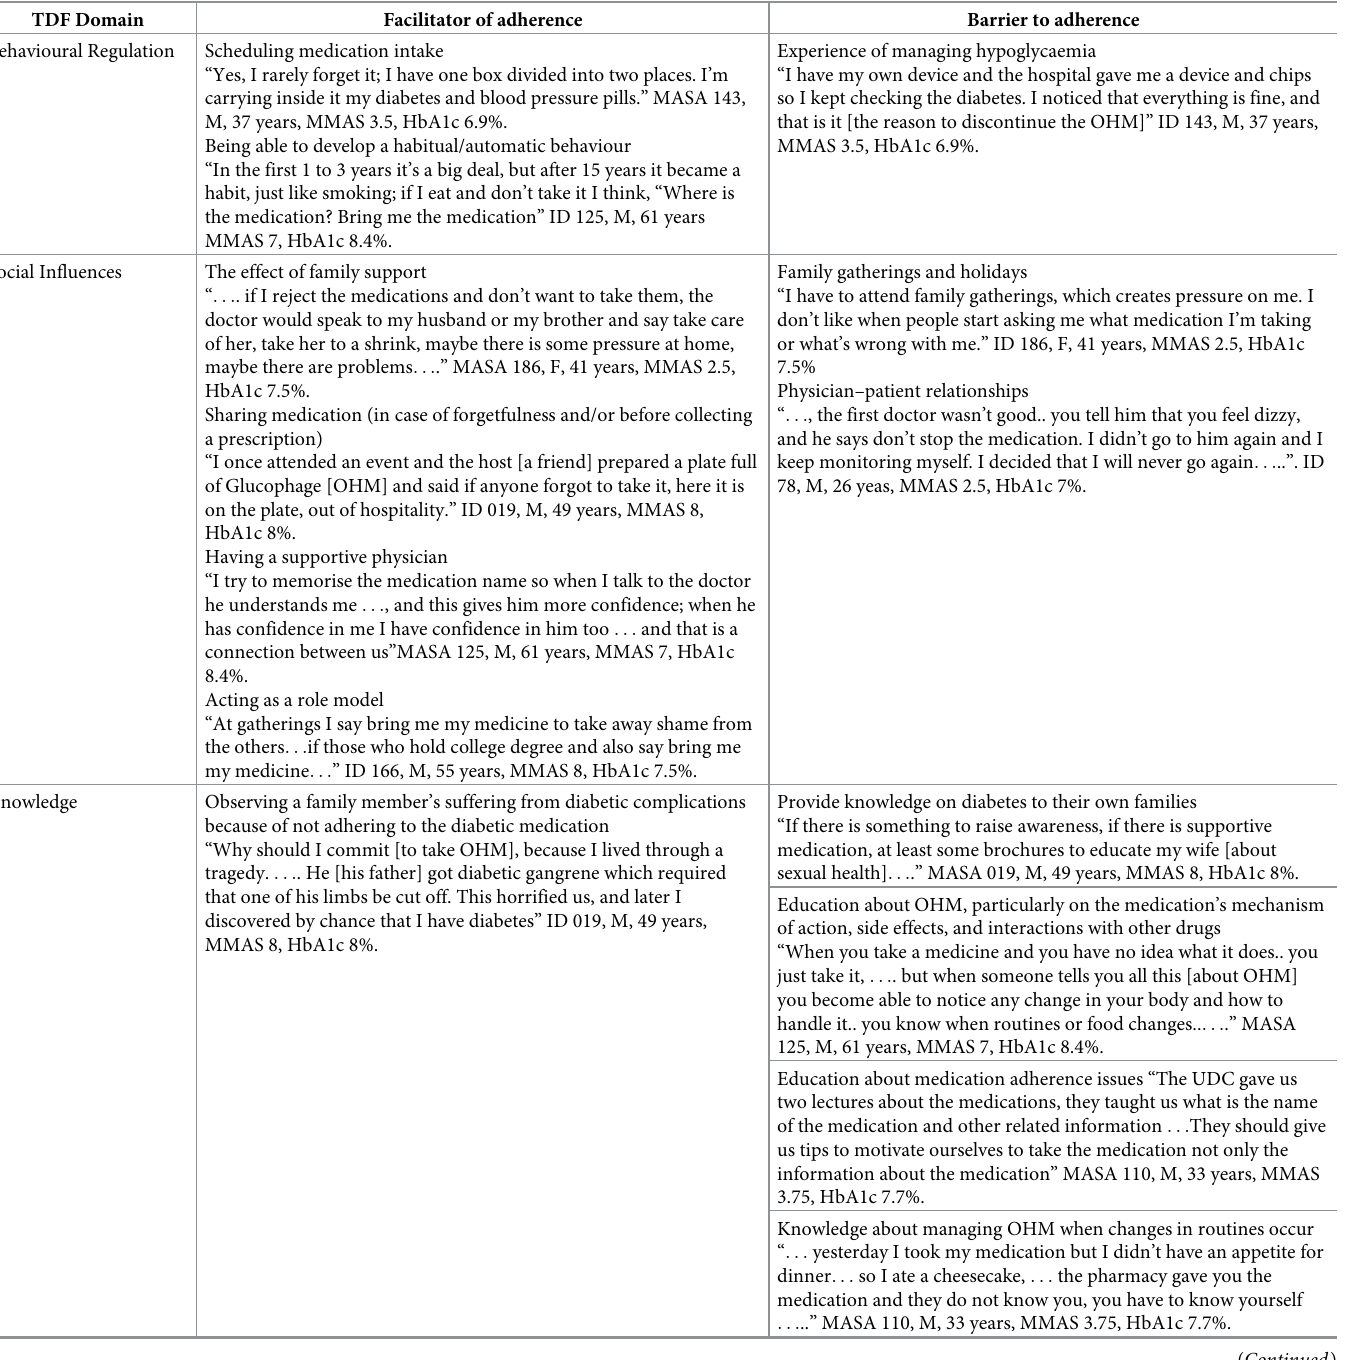
Table 3. Domains from the TDF and example quotes for barriers and facilitators of adherence behaviour. TDF